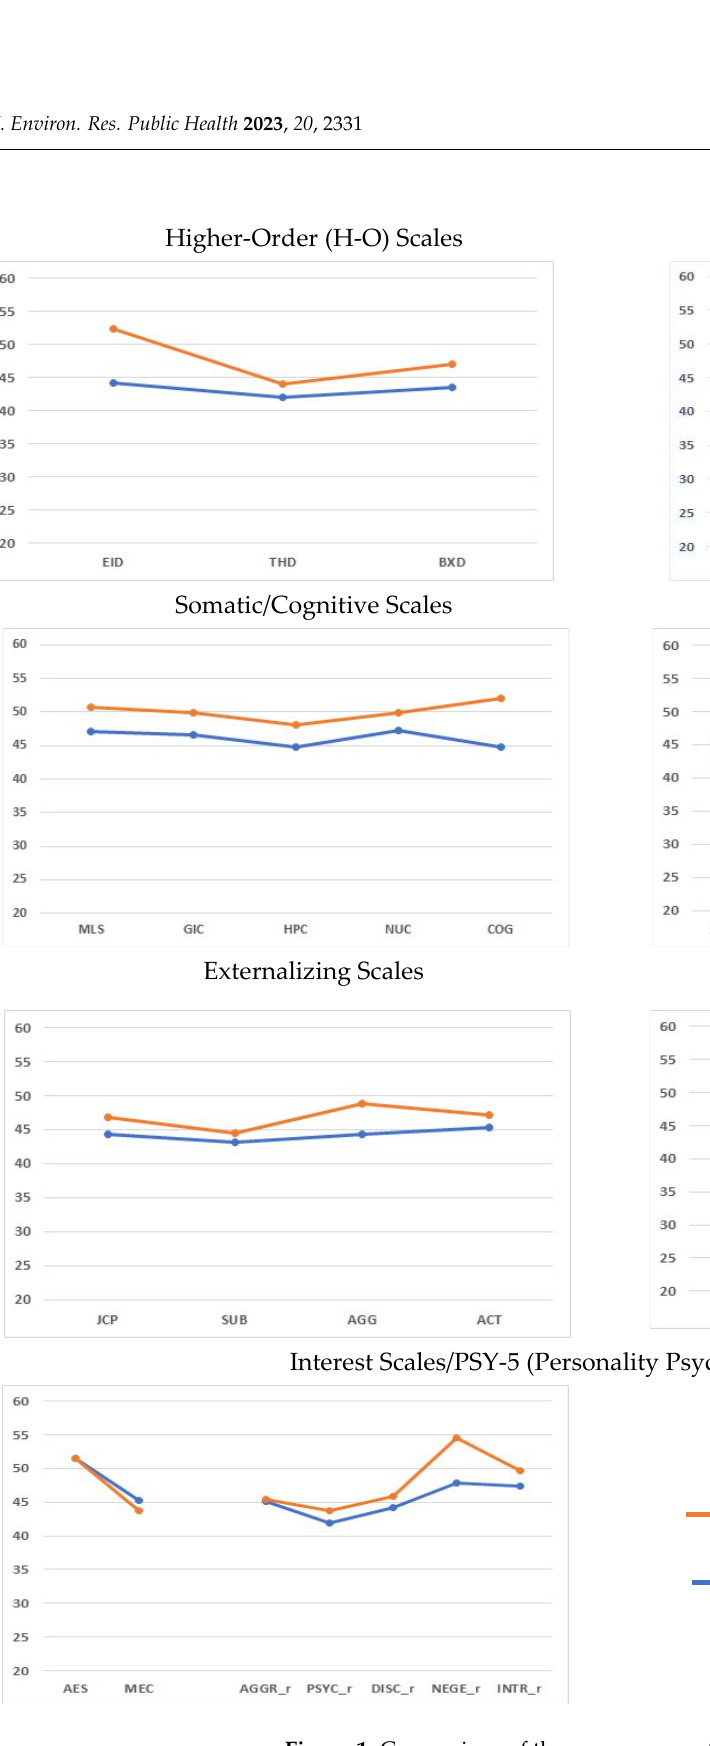
Figure 1. Comparison of the mean scores of the smartphone overdependence group and the general user group on each Minnesota Multiphasic Personality Inventory-2-Revised Form scale.